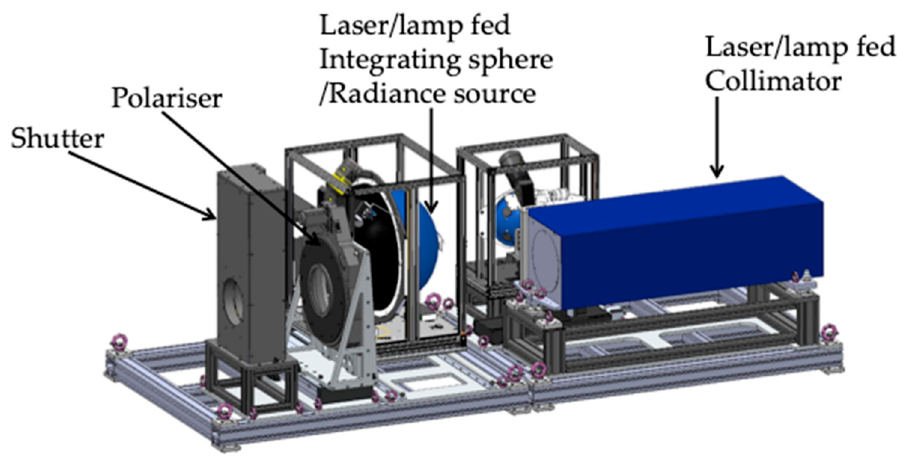
Figure 22. Computer assisted design of the STAR-OGSE-CC (excluding the laser).